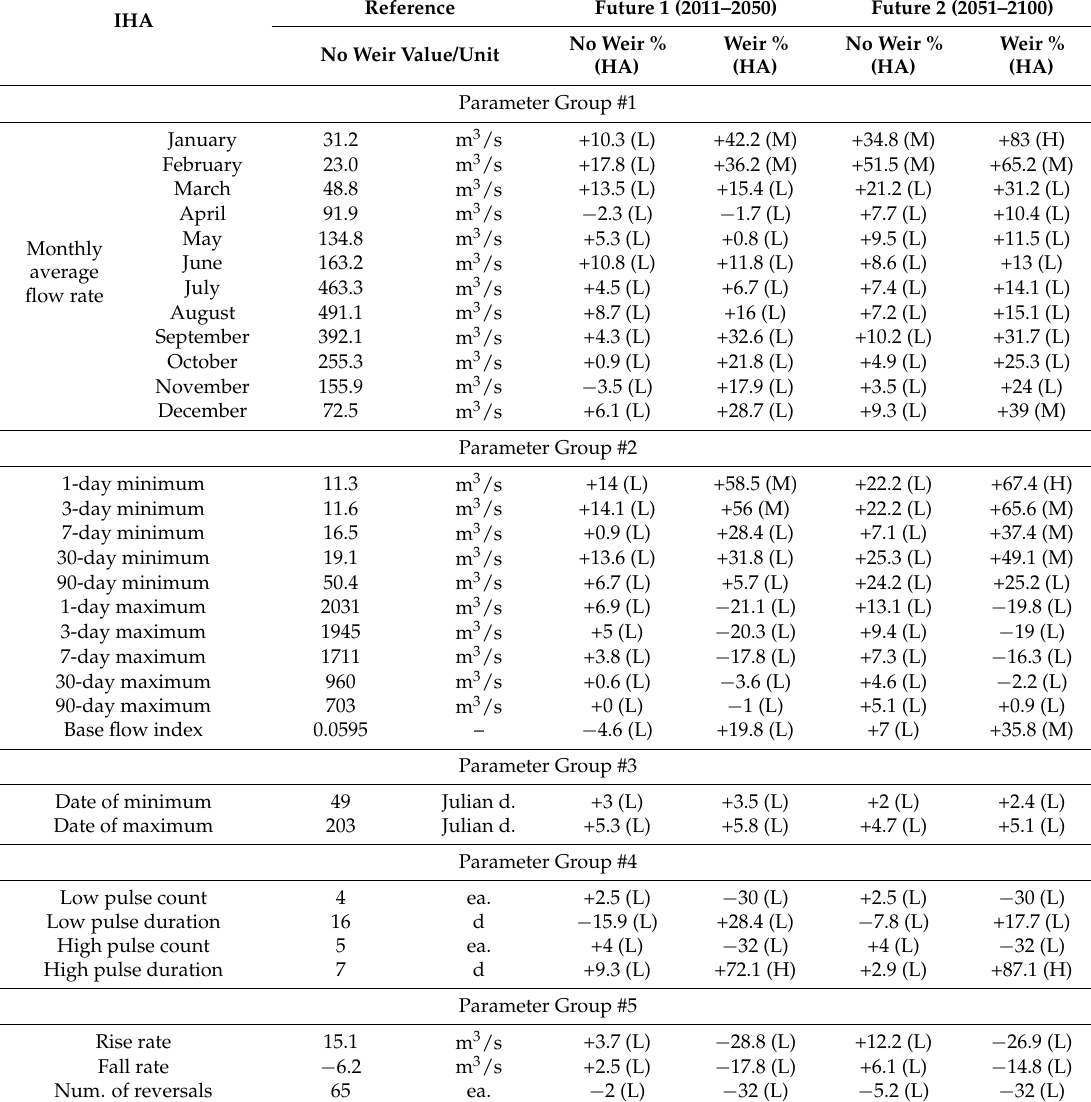
Table 7. Changes in indicators of hydrologic alteration (HA) analysis at the Gyuam